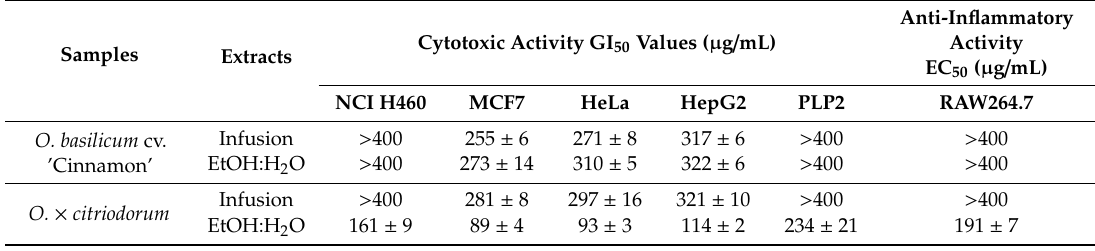
GI 50 values correspond to the sample concentration achieving 50% of growth inhibition in human tumor cell lines or in liver primary culture PLP2. Ellipticine GI 50 values: 1.21 µ g / mL (MCF-7); 1.03 µ g / mL (NCI-H460); 0.91 µ g / mL (HeLa); 1.10 µ g / mL (HepG2), and 2.29 µ g / mL (PLP2). Dexamethasone EC 50 value = 1.6 ± 0.2 µ g / mL